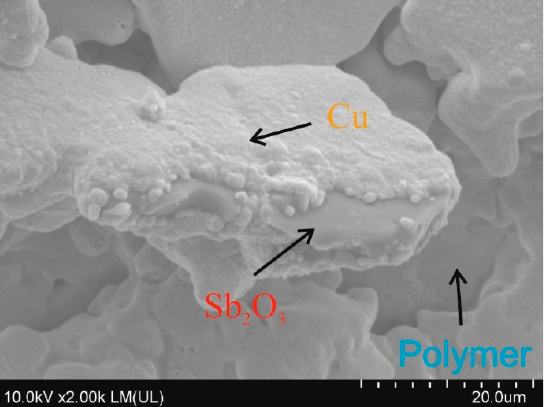
Figure 8. SEM image of B2 coating after electroless metallization. The irradiated and metallized B2 coating (Figures 7 and 8) was practically completely covered with a copper layer, except for the characteristic depressions where the matrix of the coating was not subjected to thermal ablation. The EDX analysis of metallized coatings showed 46.5 at% and 13 at% of copper on the B2 and B3 coating, respectively. On other coatings, including those with complex A, no copper was detected with this technique after the metallization process. In the previous work [15], similar studies were carried out using complex B, however, the surface modification was performer with an ArF excimer laser generating UV radiation ( λ = 193nm). The surface obtained as a result of irradiation was characterized by a completely different topography than in the case of the samples presented in this article. After the coatings were irradiated with the ArF excimer laser, their surface had a conical structure, where copper precipitation occurred at the tips of the cones as a result of the degradation of the complex. Copper was also present in the lower parts of cones but in a much smaller amount. After metallization, the surface structure of the deposited copper layer mirrored the surface structure of the substrate after laser activation. The entire surface of the cones was covered with a layer of copper, but the tops of the cones were rounded, due to a significantly large amount of deposited copper. The same effects were obtained when using another copper (II) L-tyrosine complex [17]. Thus, the effects of laser modification and electroless metallization were definitely different from those presented in this work, where copper was mainly precipitated on Sb 2 O 3 particles. In order to check the adhesive strength of the deposited copper layers, the adhesive strength tests were carried out using tensile machine by pulling off the glued stamps. The copper layer did not peel from the polymer coating in any of the samples, because the cracking